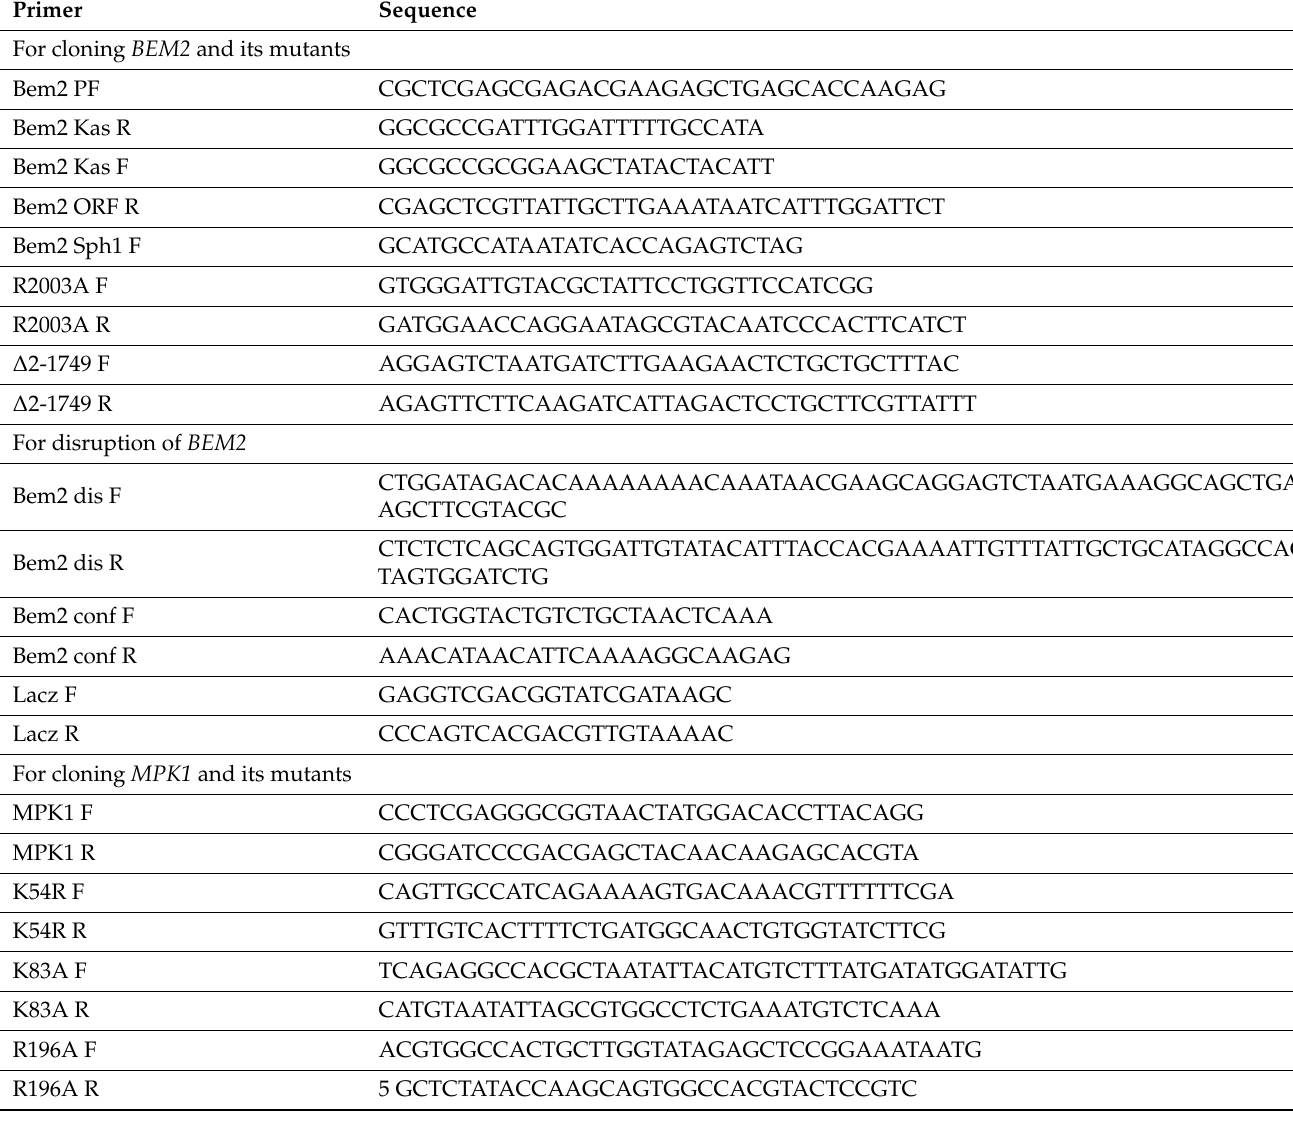
Table 1. List of Primers used in this